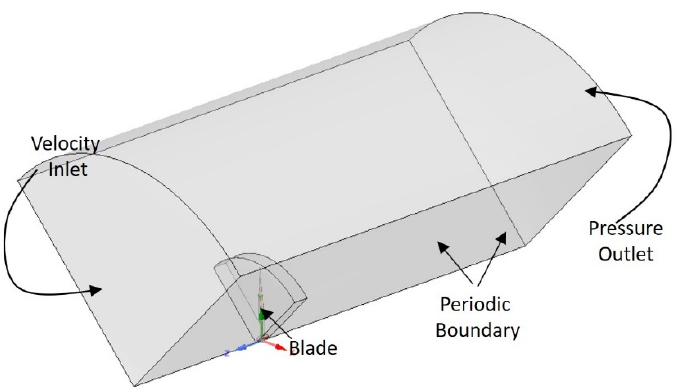
Figure 4. Computational domain and boundary with boundary conditions.